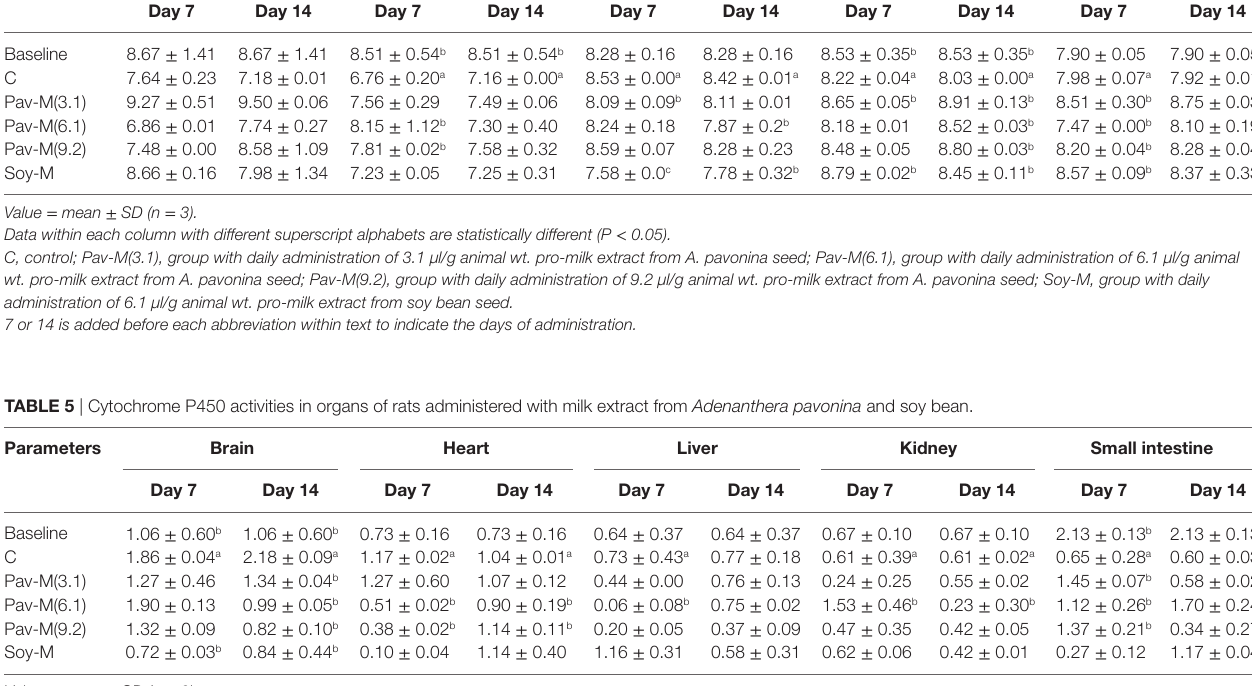
TaBle 4 | Total protein levels in organs of rats administered with pro-milk extract from Adenanthera pavonina and soy bean. Parameters Brain heart liver Kidney small intestine